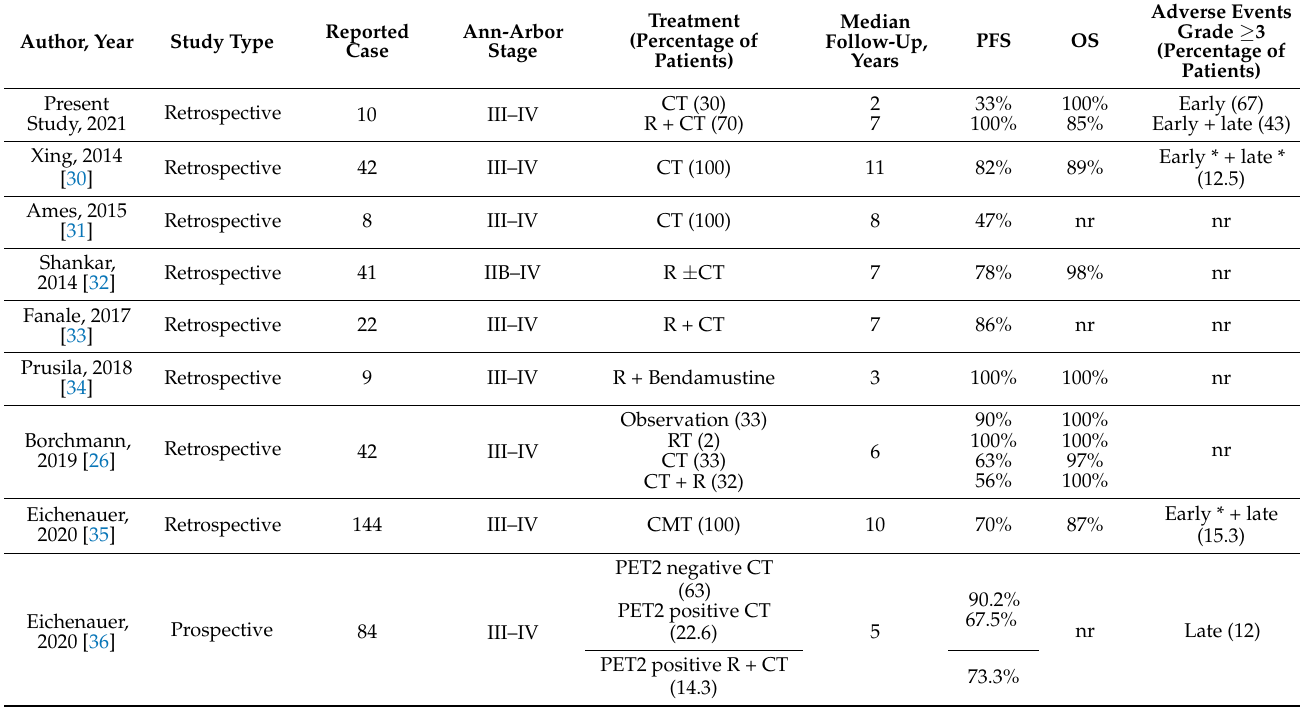
Table 4. Selected studies in advanced-stage NLPHL, showing the relatively small number of patients treated with Rituximab- containing